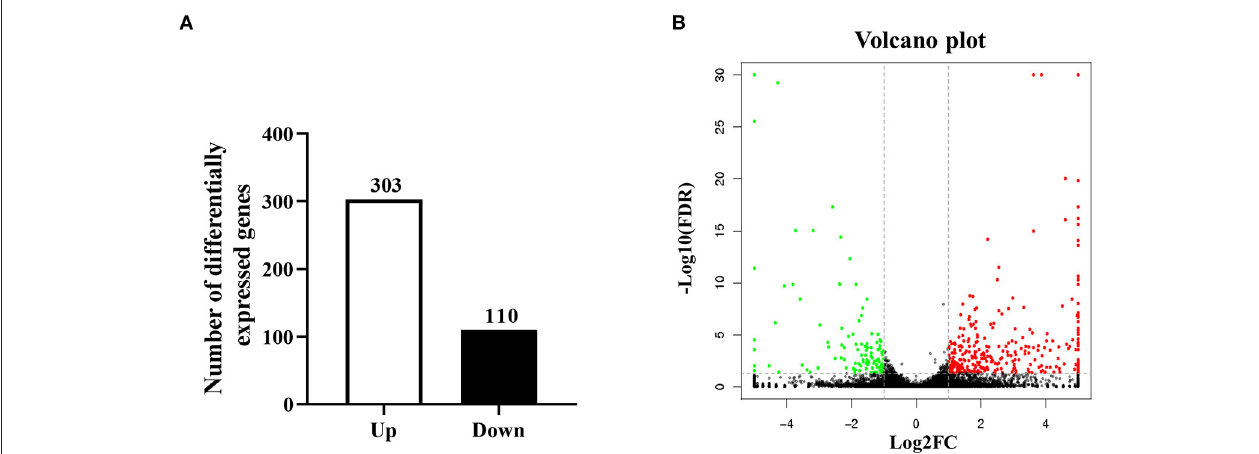
FIGURE 1 | Bioinformatics analysis of DEGs in splenic B cells infected with the larval E. granulosus . (A) The number of the DEGs. (B) The volcano plot shows the distribution of DEGs. n = 3 mice per group. The significantly up- and down-regulated RNAs are presented as red or green dots (|log2FC| > 1 and FDR < 0.05), respectively, while the expression of mRNAs not significantly differently expressed is presented as black dots.